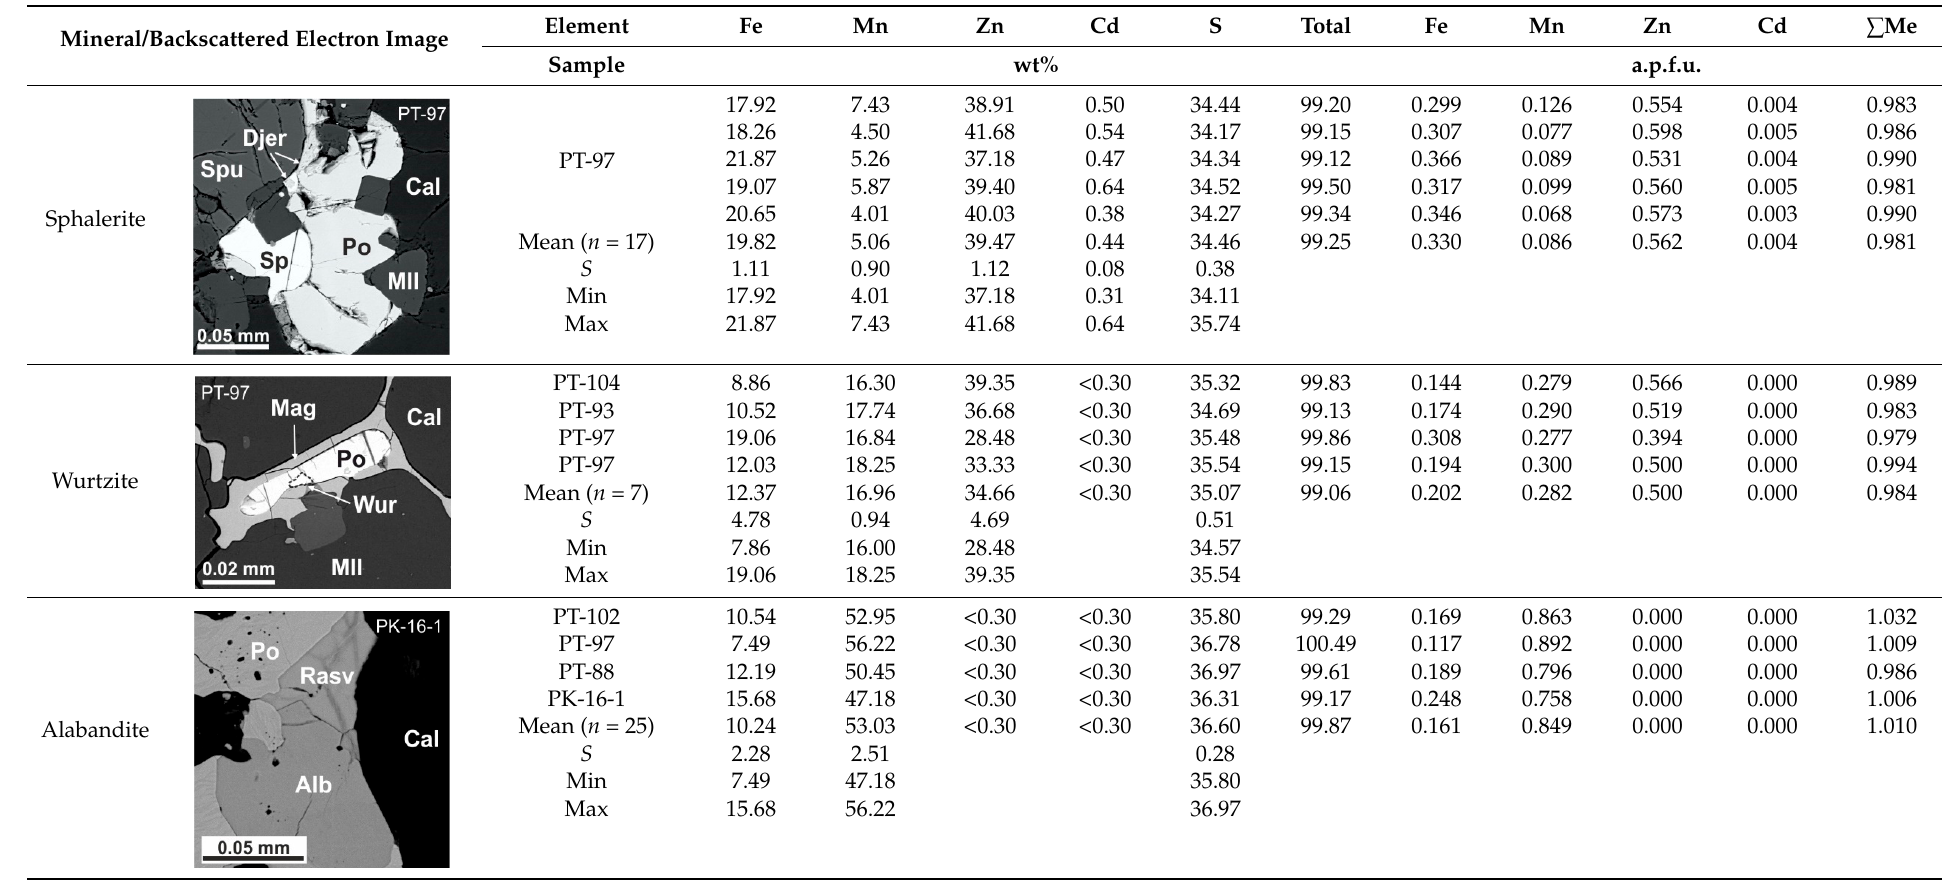
Table 6. Representative analyses and average compositions of Zn-Fe-Mn and Mn-Fe sulfides from the Kochumdek marbles (SEM-EDS data). Mineral/Backscattered electron image